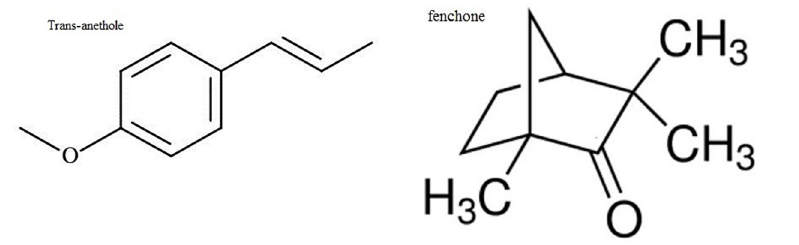
Fig 1. Structure of main components trans-anethole and fenchone.